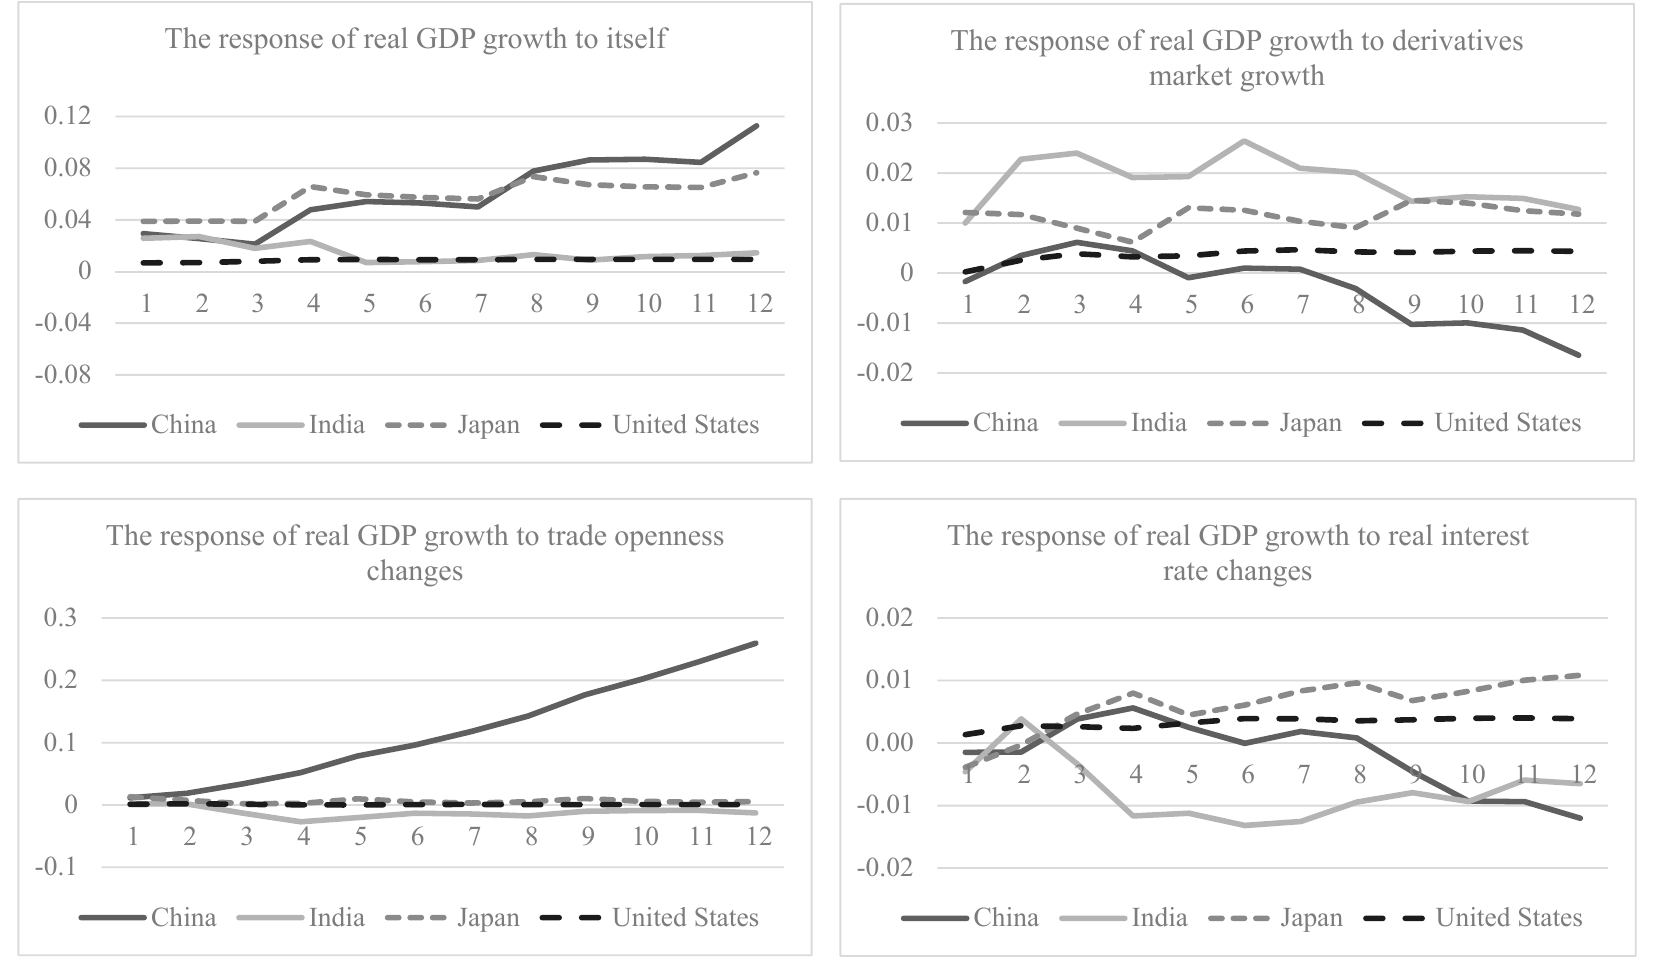
Figure 2. Cumulative orthogonalized impulse response function (the model includes GDP growth).